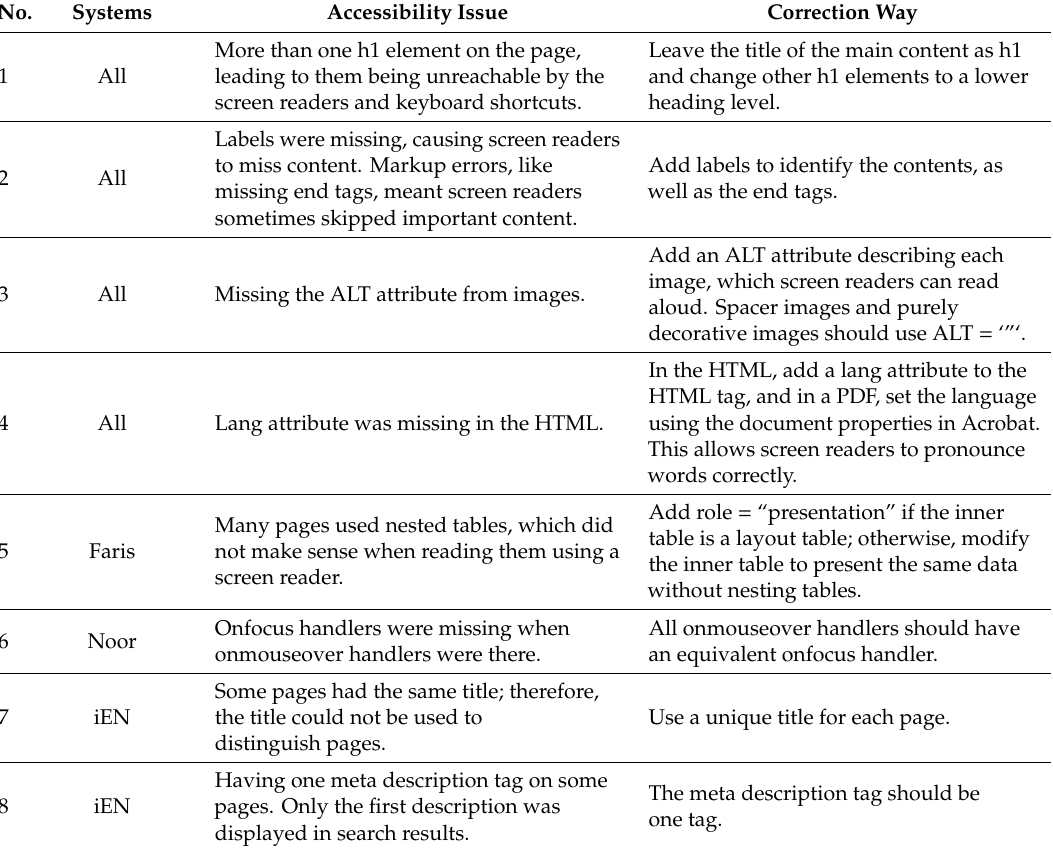
Table 14. Common accessibility issues and suggested